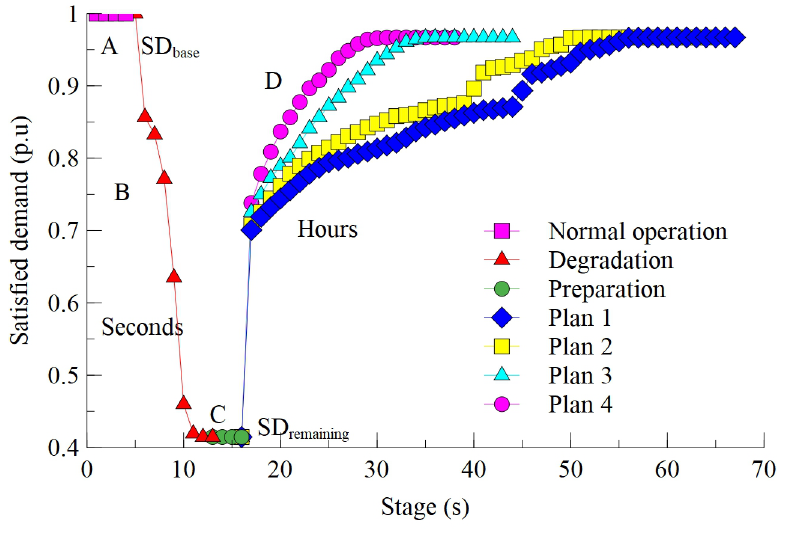
Figure 9. Recovery curves for the IEEE 118-bus test